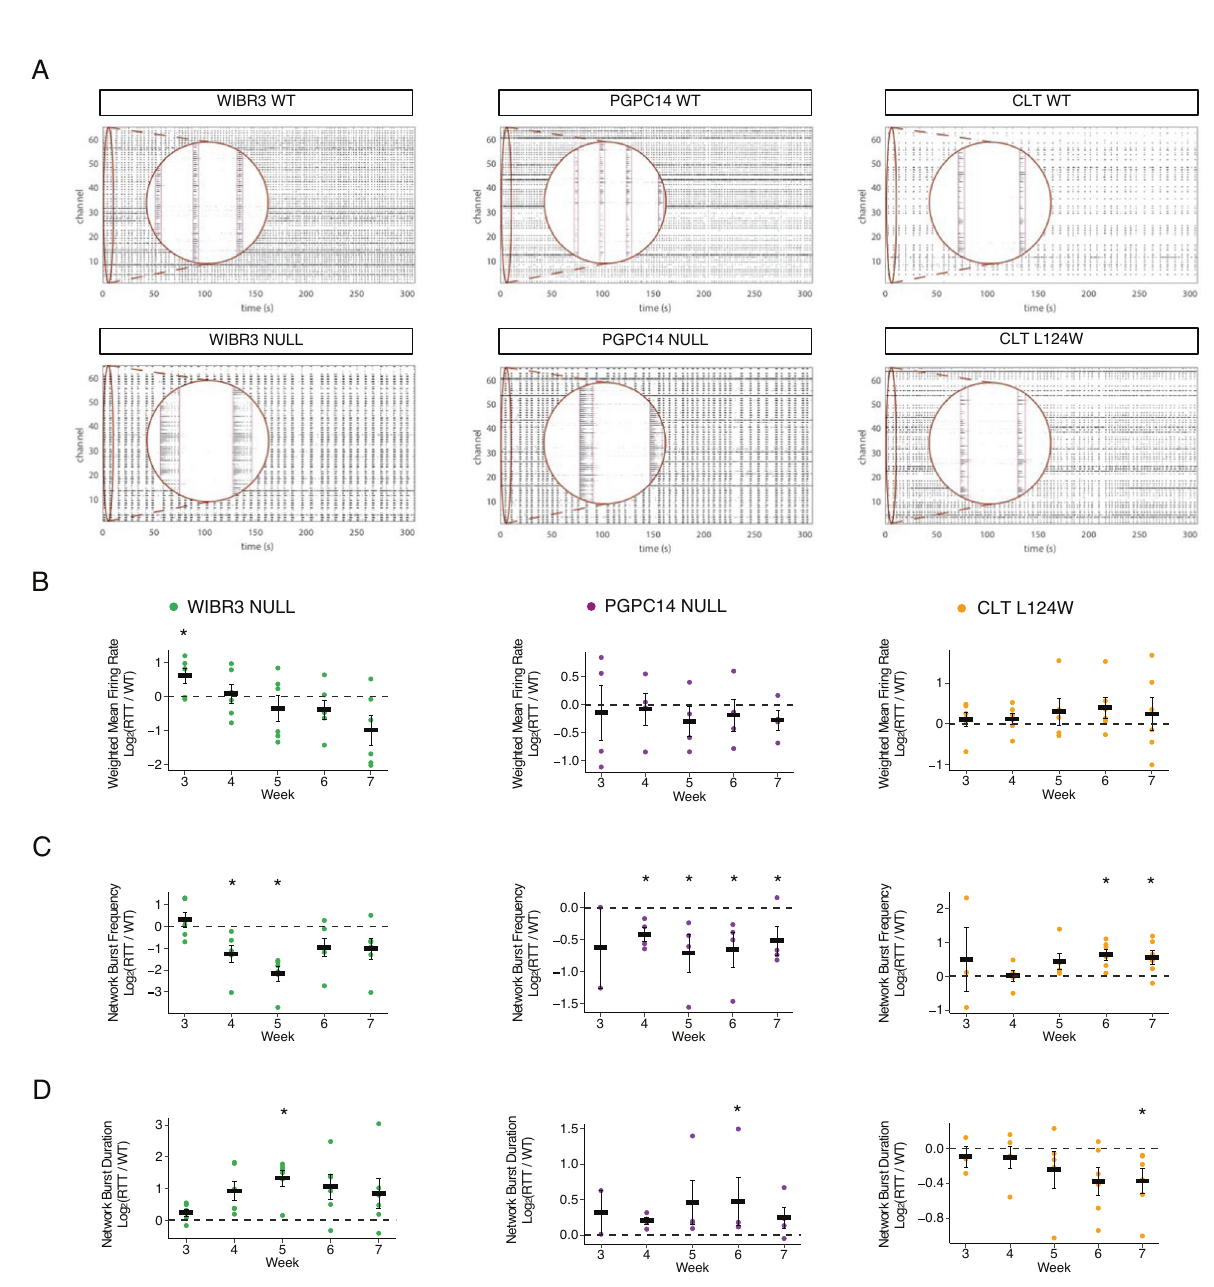
Fig. 4 MECP2 null Ngn2 neurons exhibit altered network bursting activity. A Representative 300 s MEA raster plots of spontaneous action potential spikes (black lines) from WT and RTT Ngn2 neurons co-cultured on mouse astrocytes at 5 weeks, detected across grid of 64 electrode channels. Inset (circular window) is a magni fi cation of the selected region, showing spikes across multiple channels within synchronous network bursting events. B Quanti fi cation of MEA activity shown as log fold change of RTT relative to WT for weighted mean fi ring rate, ( C ) network burst frequency, and ( D ) network burst duration. 6 replicate plates of WIBR3, 4 replicate plates of PGPC14 and 6 replicate plates of CLT isogenic pairs, with 2 – 6 active wells analyzed per genotype per plate. All data were shown as mean + / − SEM, * p < 0.05. 2 lines of isogenic WT and 2 lines of CLT L124W data were pooled. Statistical signi fi cance was evaluated by Student ’ s t -test or Mann – Whitney test, as appropriate, in Panel ( B – D ). * p < 0.05.